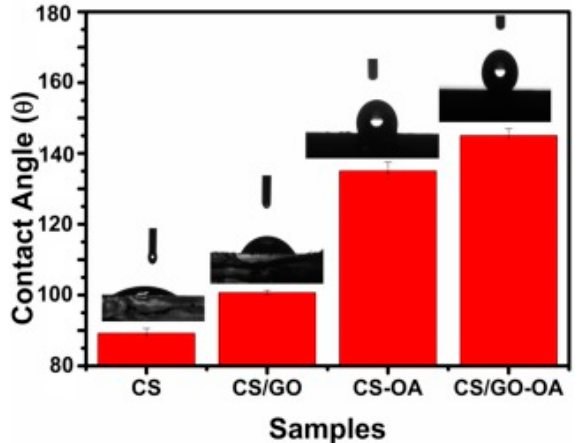
Figure 18. Water contact angles for chitosan (CS), CS/graphene oxide (GO), CS–oleic acid (OA) and oleic acid-grafted chitosan/graphene oxide (CS/GO-OA) [120].